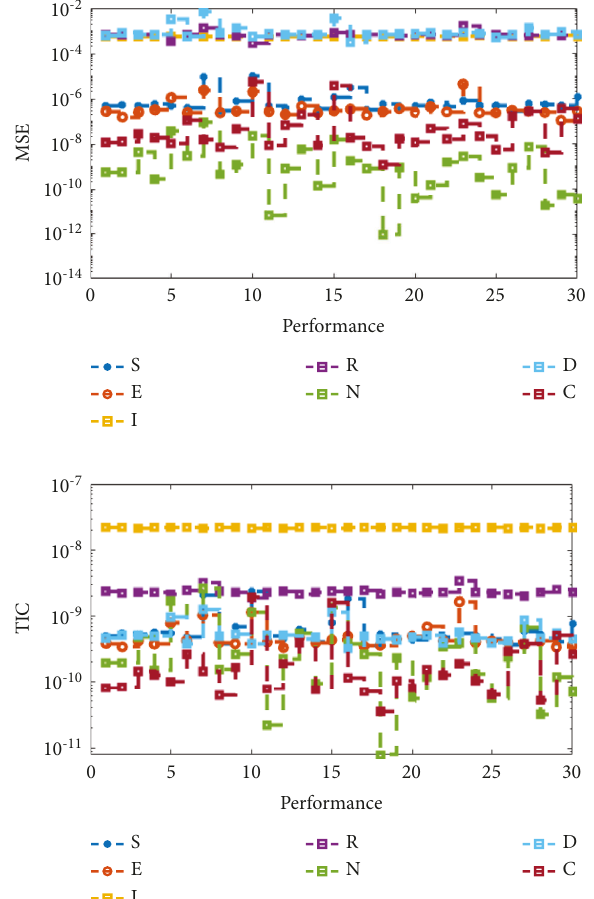
Figure 6: MSE and TIC convergence plots for the mathematical SEIR-NDC